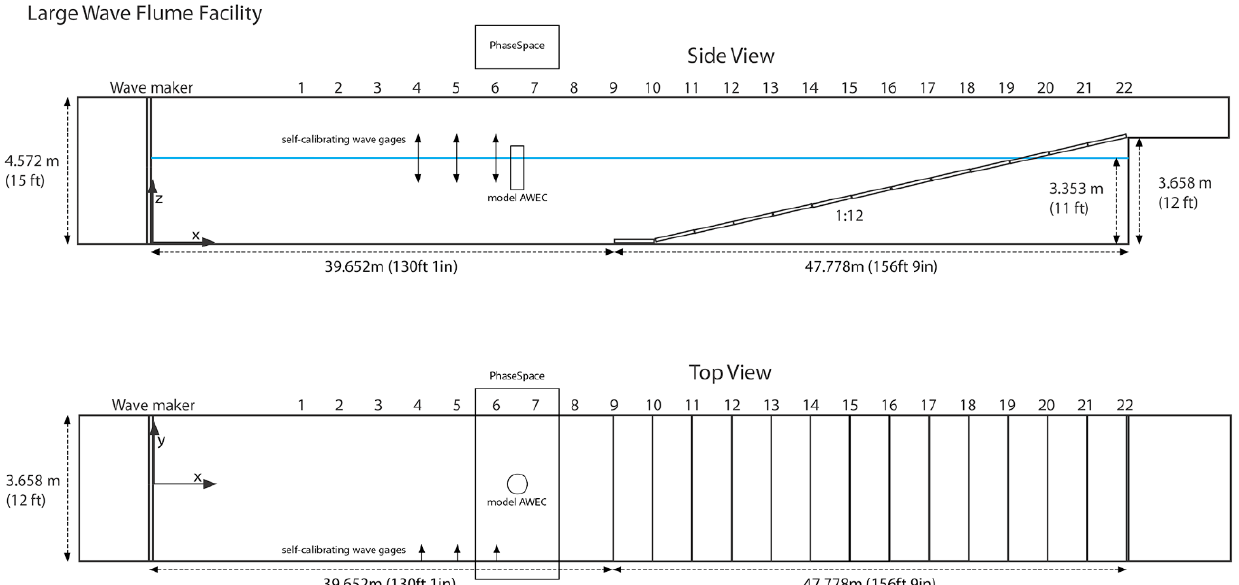
Figure 6. Large wave flume